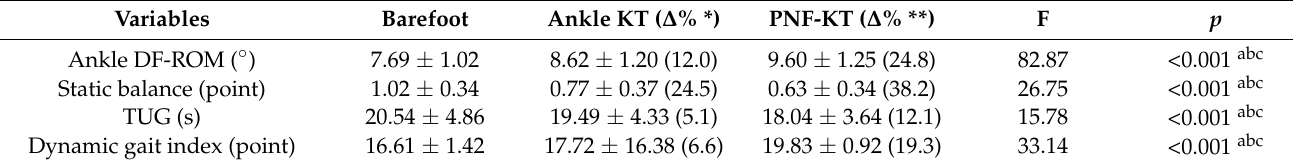
Table 2. Comparisons of variables before and after